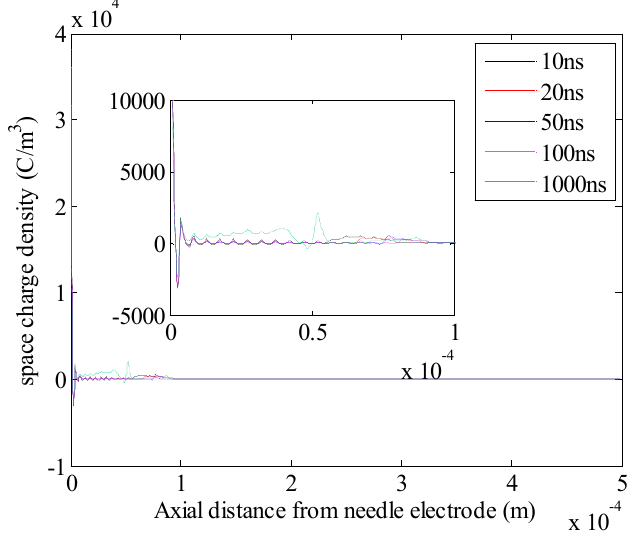
Figure 22. Space charge density distribution along the needle-sphere axis as a response to 1.2 PDIV with 10 mm needle-plate electrode configuration.